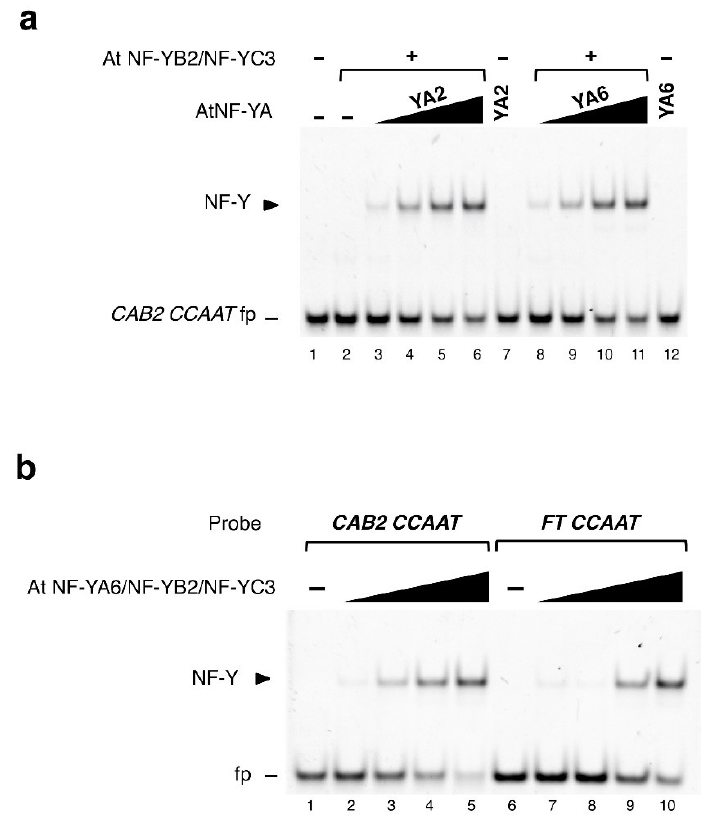
Figure 1. AtNF-YAs functionally trimerize with At NF-YB2 / NF-YC3 in electrophoretic mobility shift assay (EMSA). EMSAs were performed to assess AtNF-Y trimerization and DNA binding: ( a ) At NF-YA2 or NF-YA6 subunits were incubated at increasing concentrations (60, 120, 180, 240 nM) with the CAB2 CCAAT probe (20 nM) in presence of the At NF-YB2 / NF-YC3 histone fold domain (HFD) dimer (30 nM). As negative controls, AtNF-YAs (lanes 7, 12; 240 nM) or the HFD dimer (lane 2; 30 nM) were incubated alone with the probe; ( b ) AtNF-Y trimer composed of At NF-YB2 / NF-YC3 HFD dimer and AtNF-YA6 (1:4.5 fixed molar ratio) was used in binding reactions at increasing concentrations (40, 50, 60, 70 nM) with CAB2 promoter ( − 65 bp) or FT enhancer ( − 5.3 kb) CCAAT oligonucleotide probes (20 nM). Lanes 1, 6: Probe alone. Below, the 31mers CCAAT oligonucleotides’ sequences used in EMSA. The CCAAT pentamer is highlighted in boldface. Underlined bases were mutagenized in competitor oligos used in EMSA competition analyses shown in Figure 2a,b. ( a , b ) On the left side of each gel, an arrowhead indicates the AtNF-Y / DNA complex; fp: Free probe; purified recombinant proteins are shown in Figure S1.